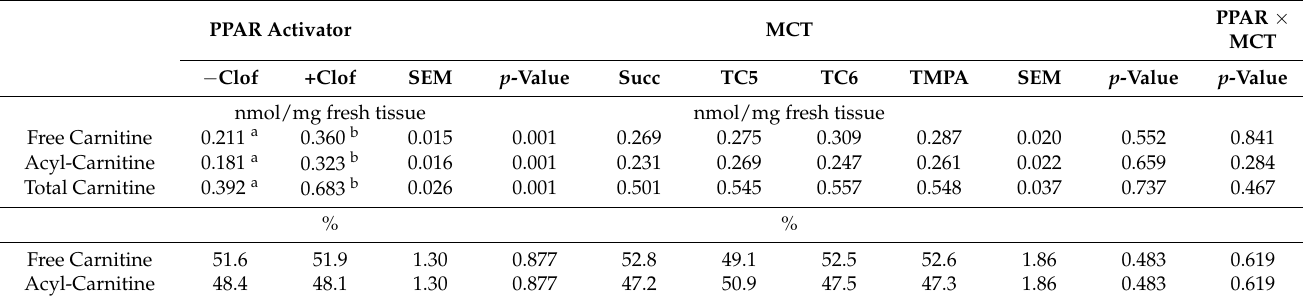
PPAR: peroxisomal proliferator active-receptor; MCT: medium chain triglycerides; Clof: clofibrate; Succ: Succinate + glycerol; TC5: tri-valerate; TC6: tri-hexanoate; TMPA: tri-2-methylpentonoate. The final column is the interaction between clofibrate and MCT. ab denotes significant ( p < 0.05) differences between groups. Values are the least square means (n = 6) ± SEM (Standard error means).